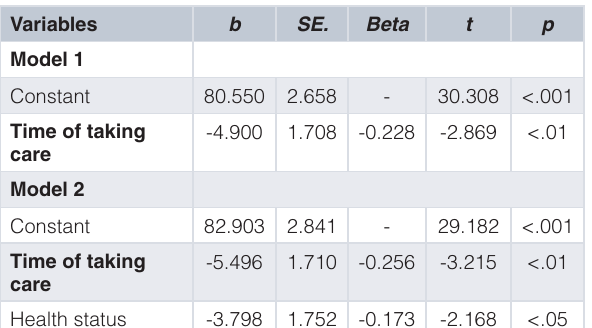
Table 6. Constant and regression coefficients of health benefits of exercise and Quality of Life among the elderly